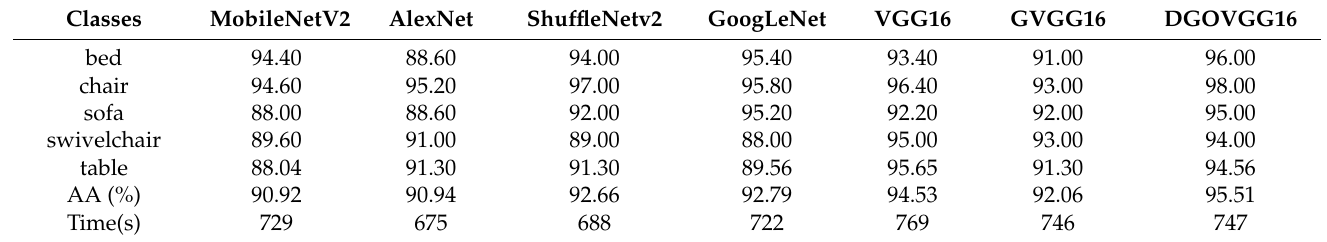
Table 4. The comparison of furniture classification results based on different network models.